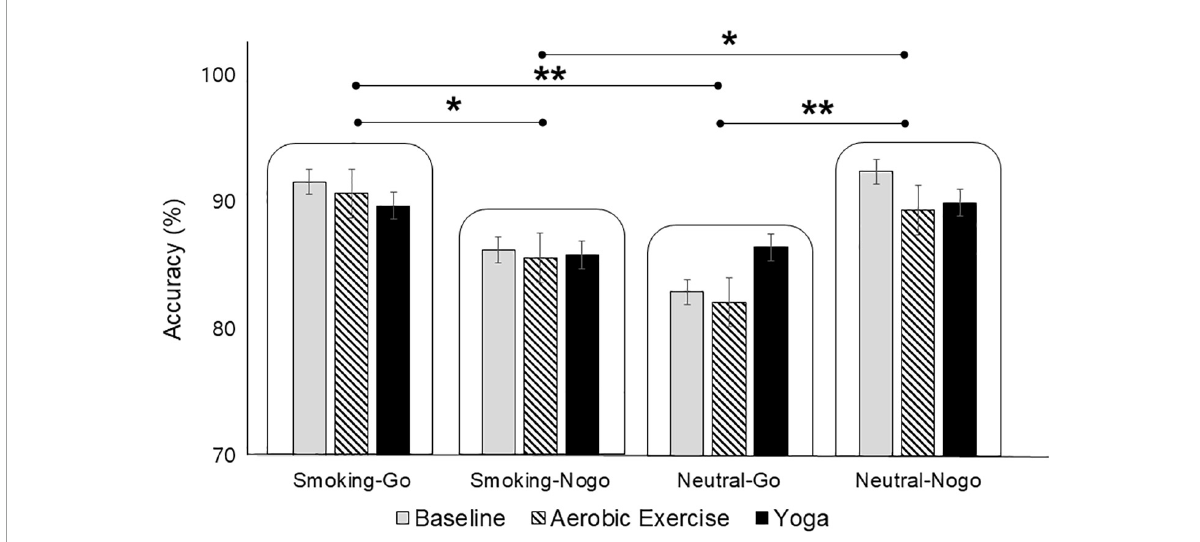
FIGURE1 Differences in Go/Nogo task performance accuracy as a function of stimulus condition. * p < 0.05; ** p < 0.01.